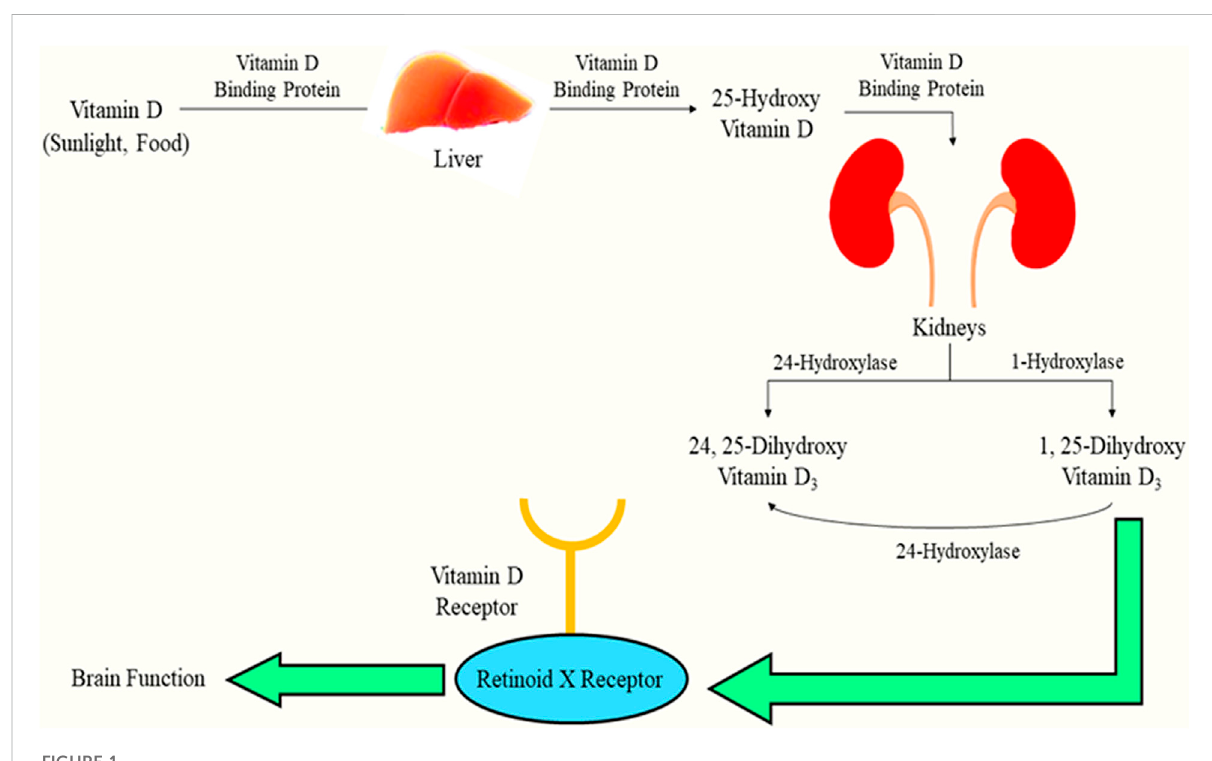
FIGURE 1 Biotransformation of vitamin D and interaction with its receptor facilitating brain